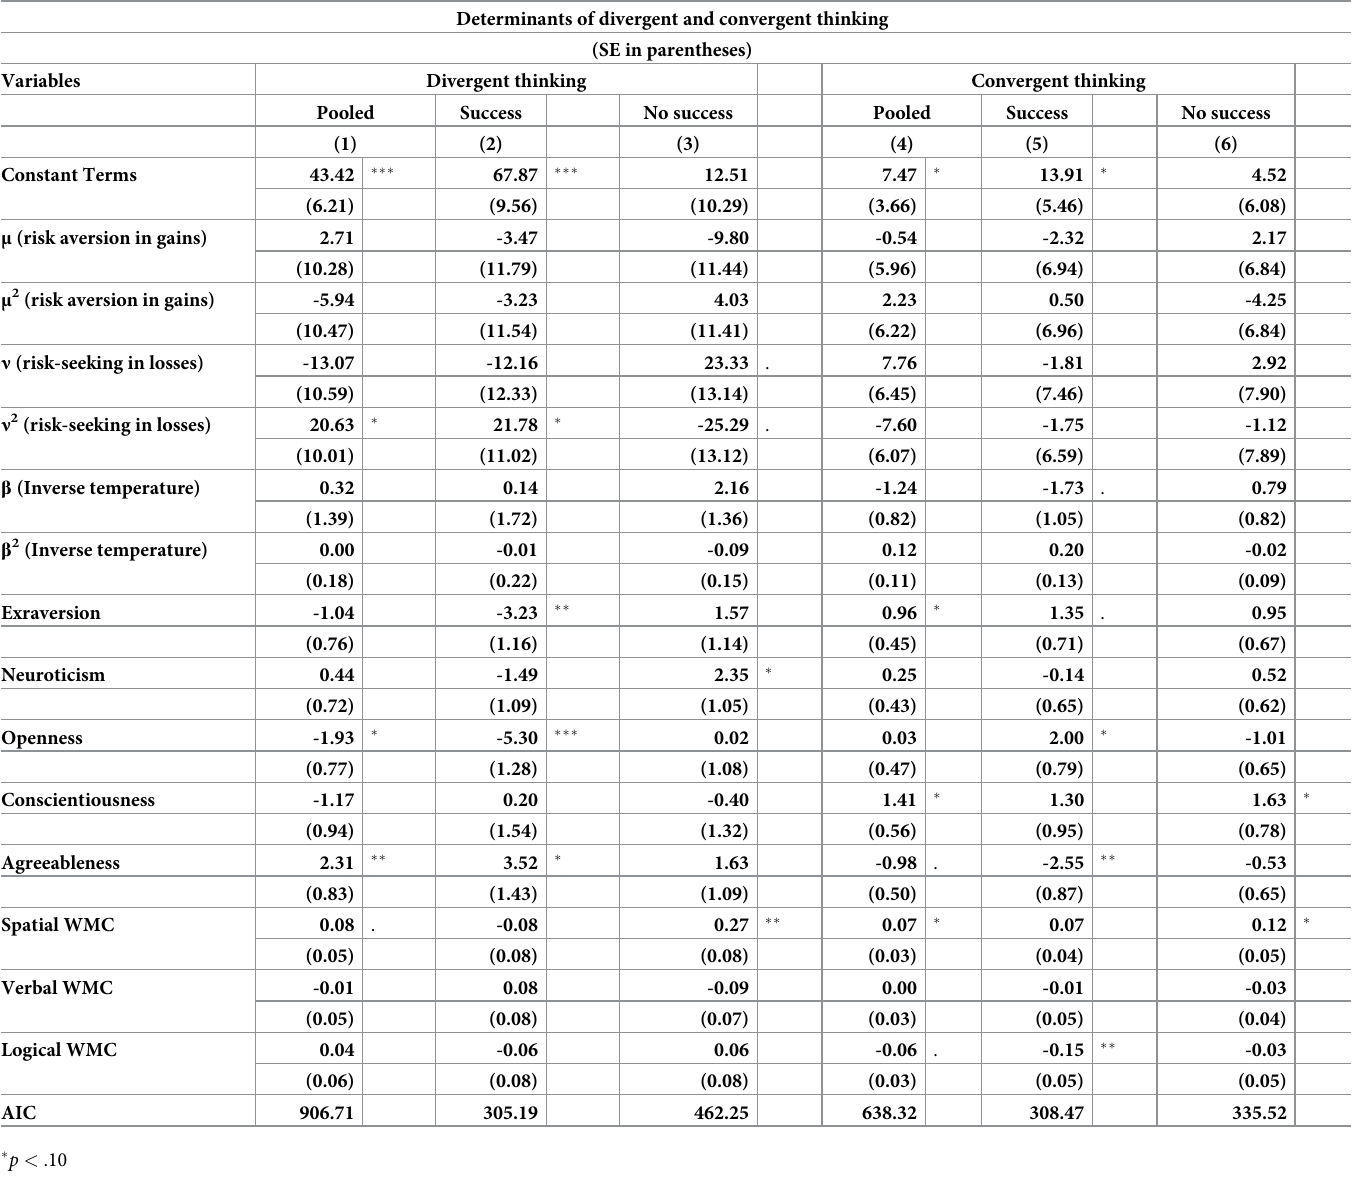
Table 3. Determinants of divergent and convergent thinking. Determinants of divergent and convergent